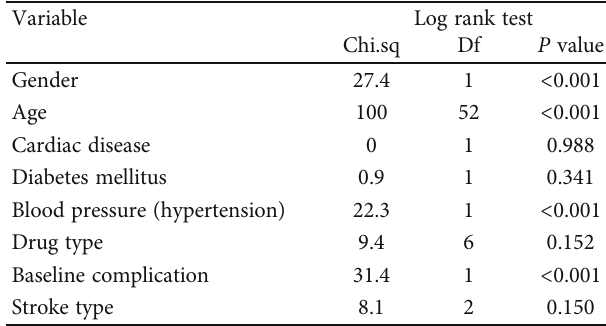
Table 2: Log rank tests of each